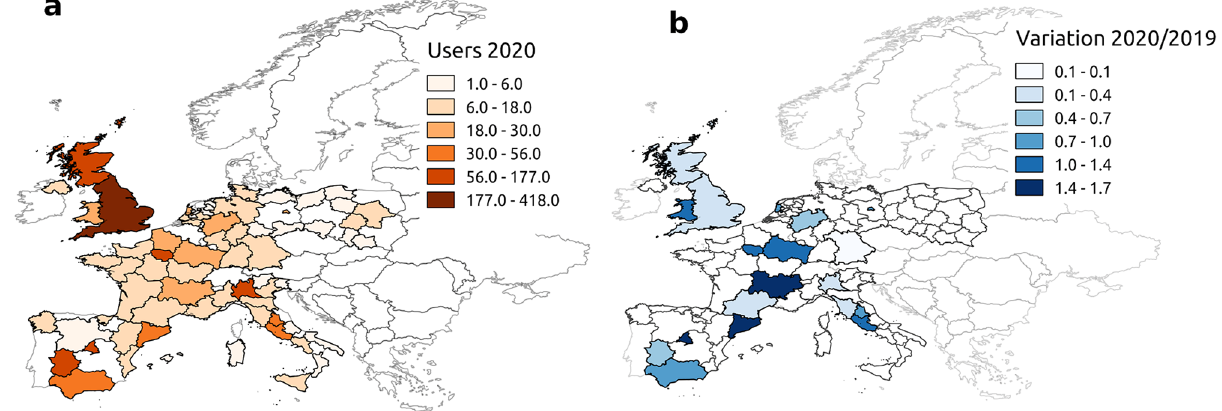
Figure 2. Geo-localization of pneumonia-related tweets posted across Europe since December 2019. ( a ) Number of users discussing pneumonia between 15 December 2019 and 21 January 2020, after filtering out press releases and news accounts. ( b ) Relative variation in number of users discussing pneumonia between winter seasons 2019 and 2020. The maps were generated using the open- source software QGIS 3.10 LTS (https ://qgis.org/it/site/).